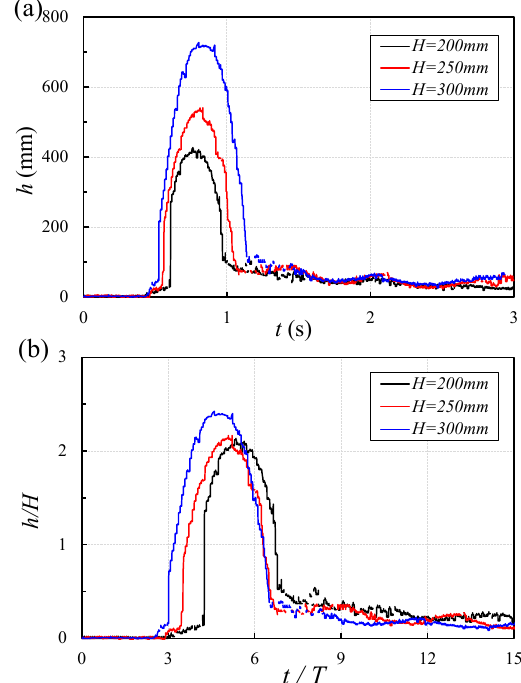
Figure 6. Time-history of the surge runup height near the vertical wall for different impoundment depths: ( a ) variations of the surge height with time; ( b ) variations of the normalized runup height with the non-dimensional time.